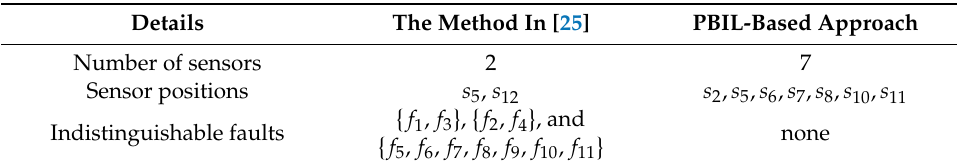
Table 3. Comparisons of the proposed approach with the approach in Reference